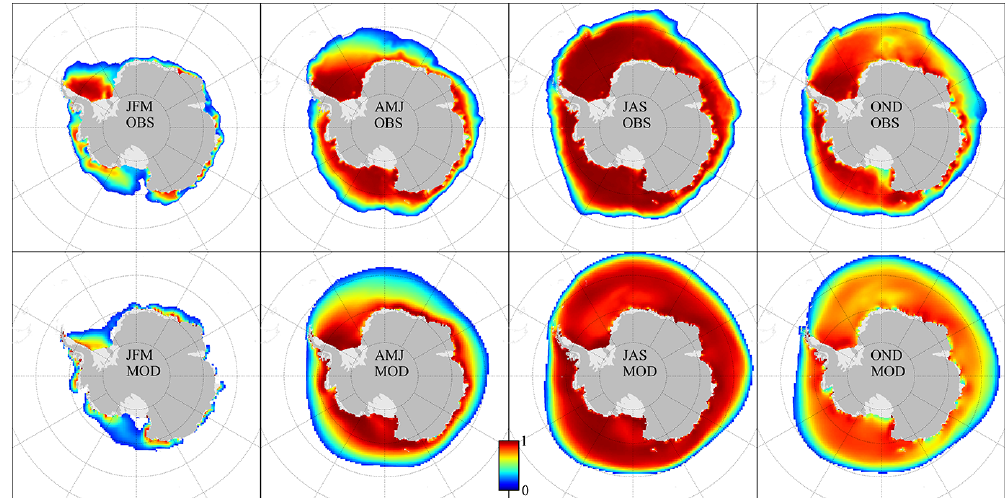
Fig. 5. Mean (1985–2011) seasonal observed (top row) and modelled (bottom row) ice concentration. Ice concentration observations calcu- lated using the Bootstrap algorithm (Comiso, 1999). Ice concentrations less than 0.15 are masked in both data sets. JFM: January–March (summer), AMJ: April–June (autumn), JAS: July–September (winter), OND: October–December